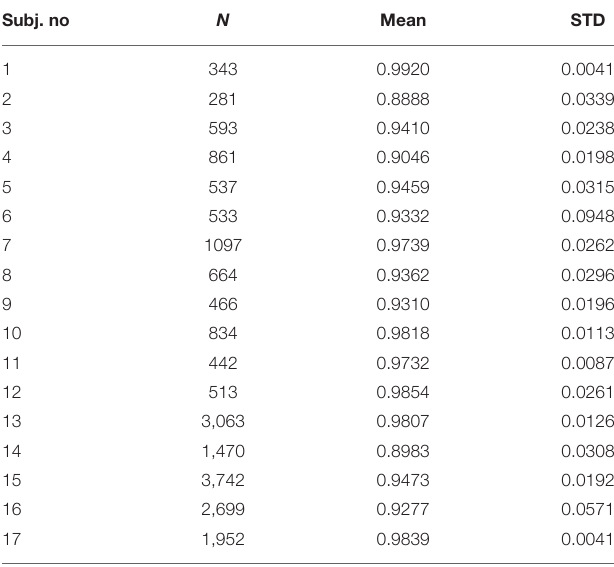
TABLE 2 | Mean and standard deviation of Pearson correlation coefficient r across 17 subjects.